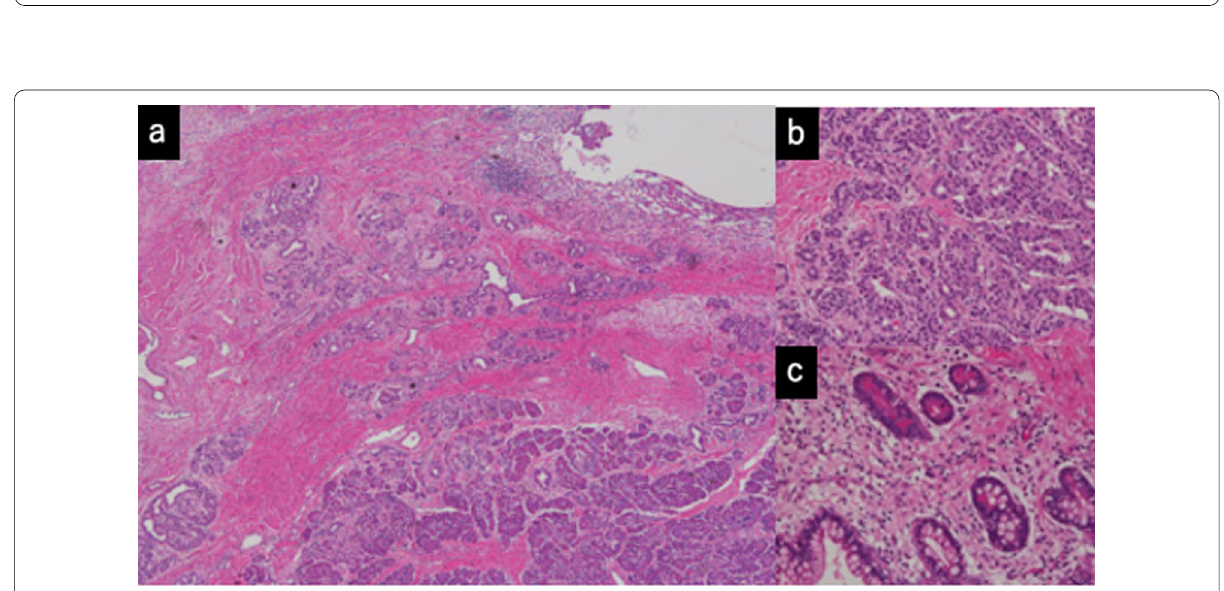
Fig. 4 a Microscopically, multilocular cysts were observed in the thymic tissue. b The cystic spaces were lined by stratified squamous epithelium. Areas containing inflammatory infiltrates, multinucleated giant cells and Hassall’s corpuscles (arrow) were observed